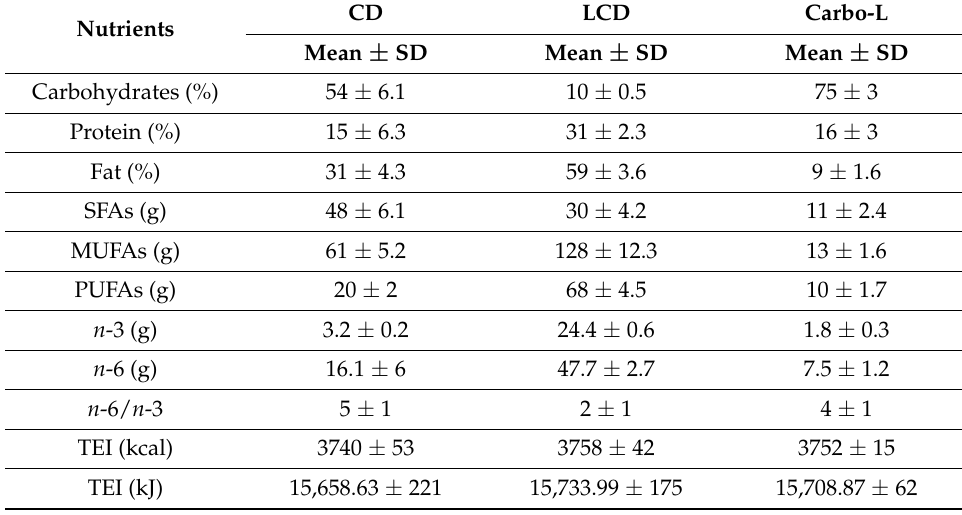
Table 2. Average macronutrients and total energy intake during the CD, LCD, and Carbo–L dietary